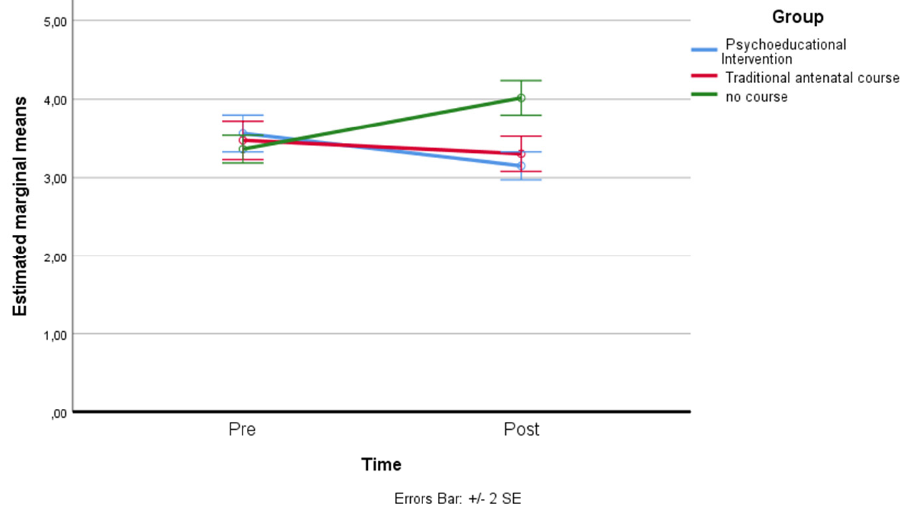
Figure 7. Estimated marginal means of past focus.